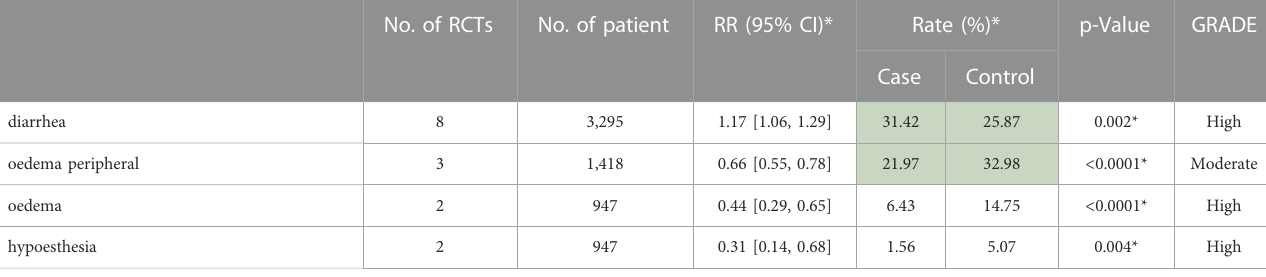
Table 6 displayed the AEs results of CT vs. ET. 1) ET: in endocrine therapy, the increased incidence of proteinuria (Rate: 8.22% vs. 0.00%, RR = 8.66), hypertension (Rate: 19.28% vs. 2.26%, RR = 2.48) and elevated aspartate transaminase (AST) (Rate: 2.60% vs. 0.53%, RR